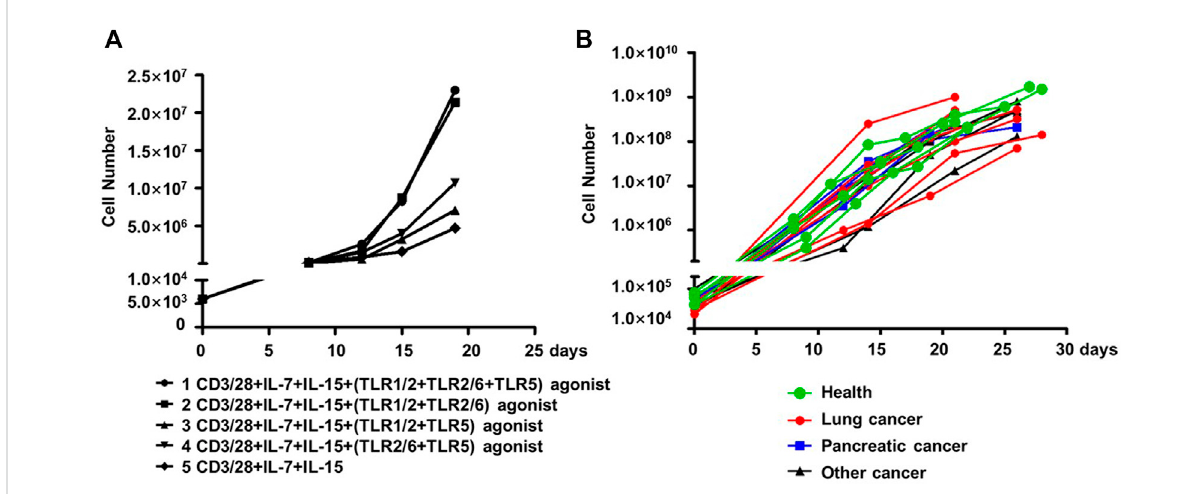
FIGURE 3 TLR agonists is an advantageous supplement bene fi ting the ex vivo expansion of human blood-derived PD1+ CD8 + T cells. (A) Exploration of optimal combination of TLR agonists in facilitating the ex vivo expansion of human blood-derived PD1+ CD8 + T cells. PD1+ CD8 + T cells isolated from blood samples of health individuals were continuously cultured for 21 days in medium containing anti-CD3/anti-CD28 beads and IL-7/IL-15, either alone or in the presence of different combination of TLR1/2, TLR2/6, and TLR5 agonists. Cell counting was performed at various time pointsthroughoutthecultureperiodtogenerate thecellexpansioncurve. (B) Expansioncurves ofPD1+CD8 + Tcellsderivedfrombloodsamplesof cancerpatientswithdifferenttumortypes.Amongthetotalof fi fteensamples,sevenwerewithlungcancer,fourwithpancreaticcancer,andtherest four with other types of cancers. Five samples from healthy individuals were also included as